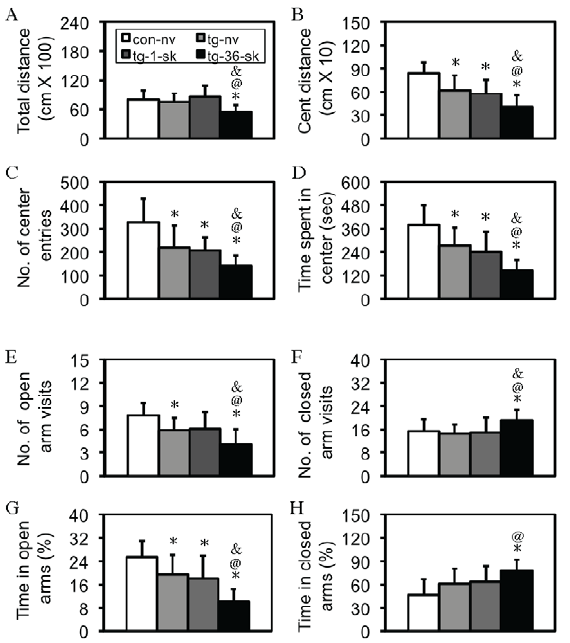
Figure 4. Enhanced anxiety-like behavior in tg mice following 36 trials of footshock. (A–D) Anxiety-like behavior in the open-field test. (A) Total distance traveled (total distance). *, p , 0.05, compared to naı¨ve control mice (con-nv; n=9); @ , p , 0.05, compared to naı¨ve tg mice (tg-nv; n=10); & , p , 0.05, compared to tg-1-shock mice (tg-1-sk; n=9). Tg-36-sk indicates tg mice subjected to 36 trials of footshock (n=10). (B) Distance traveled in center area (cent distance). *, p , 0.05– 0.001; @ , p , 0.05–001, & , p , 0.05, the same group comparisons. (C) Number of center area entries (No. of center entries). *, p , 0.05–0.001; @ , p , 0.05, & , p , 0.05, the same group comparisons. (D). Time spent in center area (time spent in center). *, p , 0.05–0.001; @ , p , 0.01, & , p , 0.05, the same group comparisons. All are post-hoc analyses following a two-way ANOVA. Data are expressed as mean 6 SD. (E–H) Anxiety-like behavior in the EPM test. (E) Number of open arm visits. *, p , 0.05–0.001; @ , p , 0.05, & , p , 0.05, the same group comparisons. (F) Number of closed arm visits. *, p , 0.05; @ , p , 0.01, & , p , 0.05, the same group comparisons. (G) Time spent in open arms. *, p , 0.05–0.001; @ , p , 0.01, & , p , 0.05, the same group comparisons. (H) Time spent in closed arms. *, p , 0.01; @ , p , 0.01, the same group comparisons. All are post-hoc analyses following a two-way ANOVA. Data are expressed as mean 6 SD.